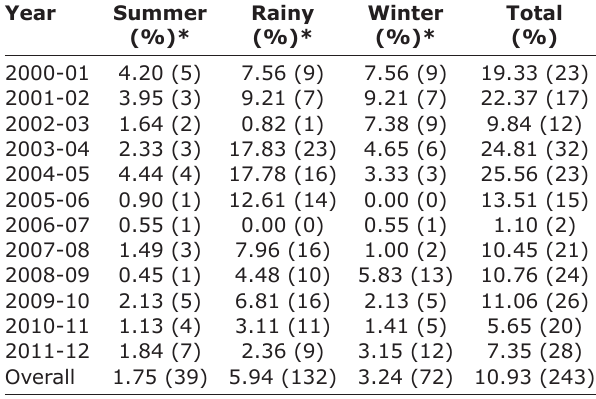
Table-1: Year and season-wise mortality rate in Rohilkhandi local